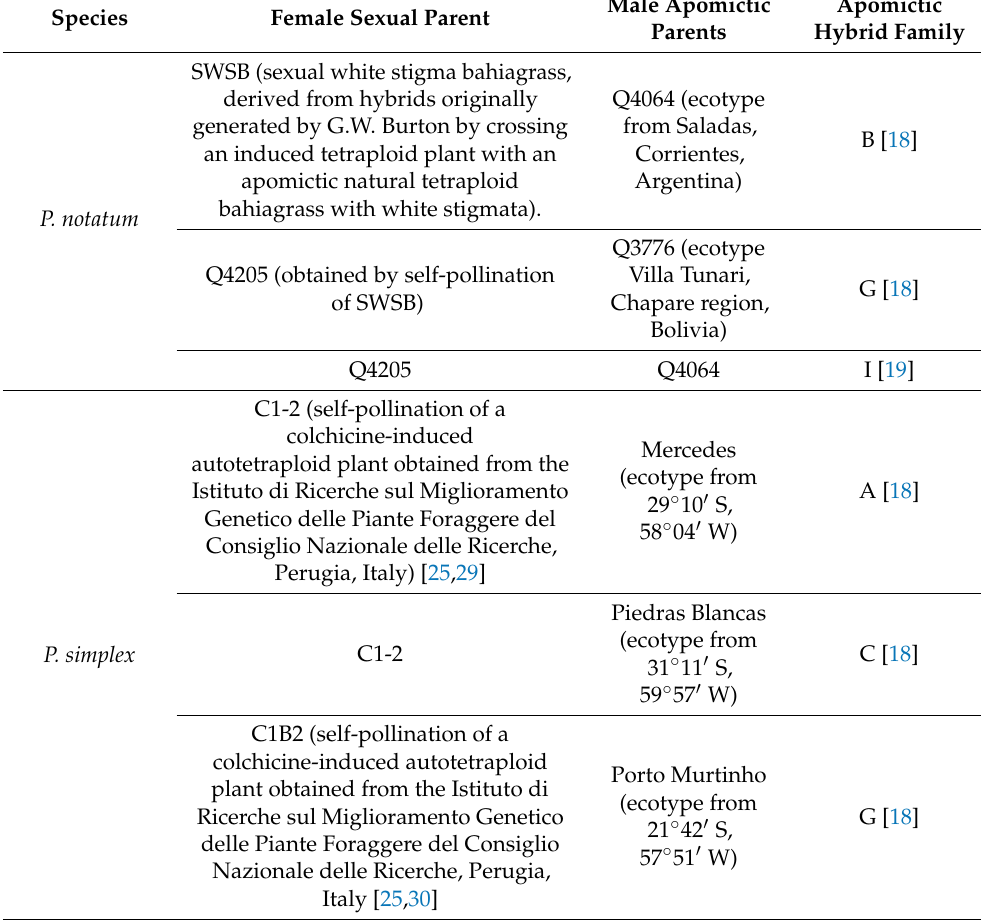
Male Apomictic Apomictic Parents Hybrid Family Q4064 (ecotype from Saladas, Corrientes, Q3776